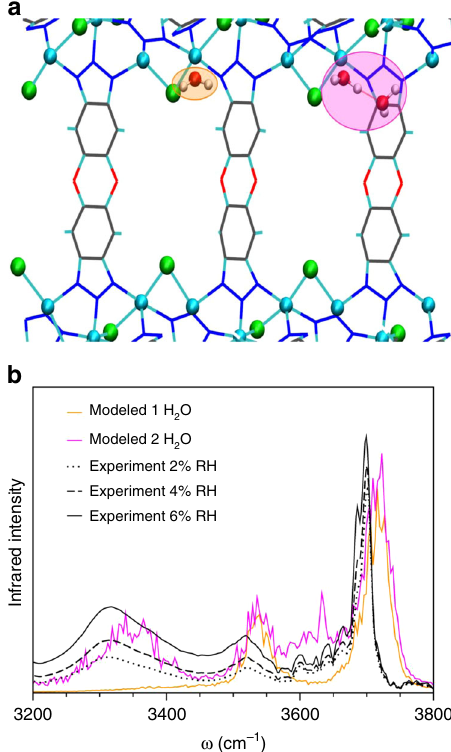
Fig. 3 Water at Low Loadings in Co 2 Cl 2 BTDD. a Simulations with one (orange) and two (pink) water molecules. Distance shown along the z- axis is 24 Å. b Calculated IR OH-stretches of one (orange) and two (pink) water molecules with corresponding experimental DRIFTS spectra at RH 2% (dotted black), 4% (dashed black), and 6% (solid black)